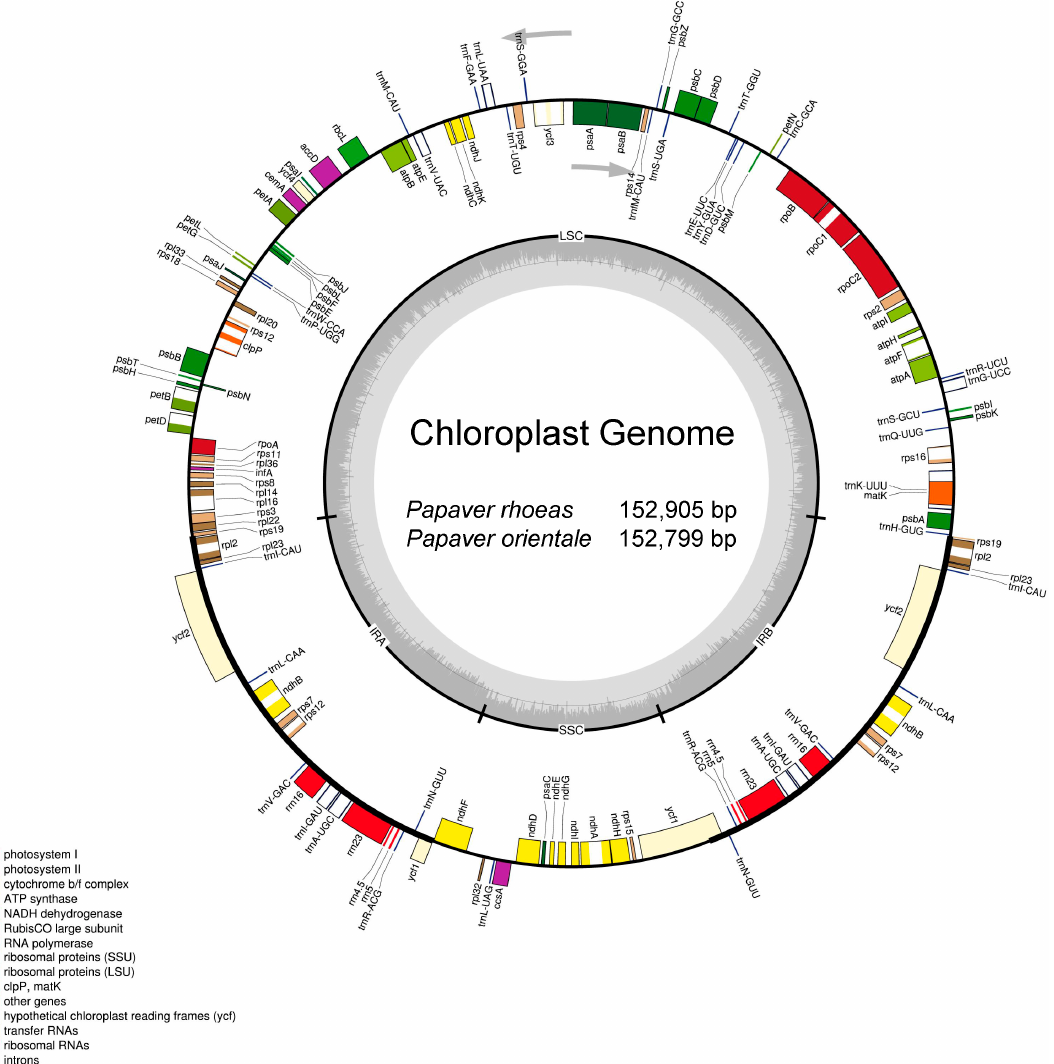
Figure 1. Gene map of the complete chloroplast genomes of P. rhoeas and P. orientale . Genes inside the circle are transcribed clockwise, whereas those on the outside are transcribed counter-clockwise. The darker gray area in the inner circle corresponds to GC content, whereas the lighter gray area corresponds to AT content. Table 1. Base composition in the chloroplast genomes of P. rhoeas and P. orientale.